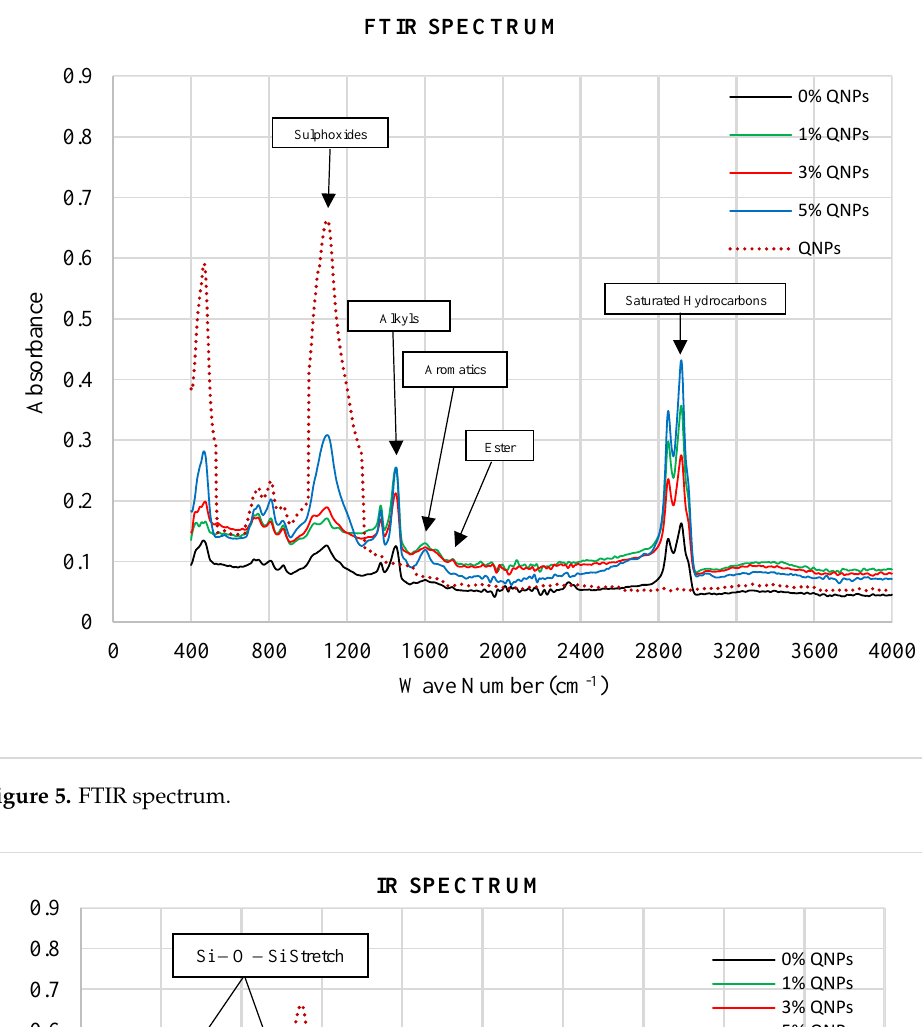
Figure 5. FTIR spectrum.